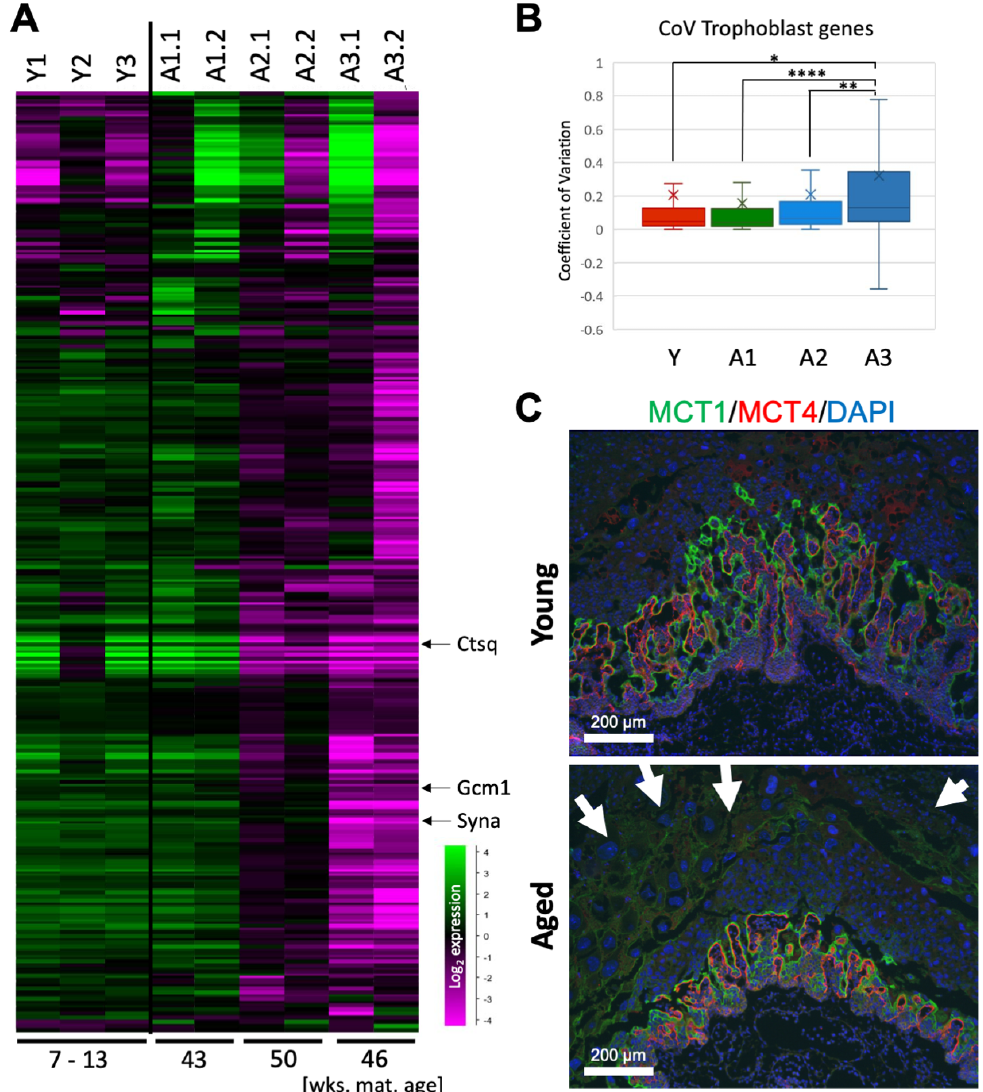
Figure 4. Impact of AMA on the trophoblast compartment of the placenta. ( A ) Heatmap depicting gene expression levels of trophoblast-enriched genes in placental samples. Key trophoblast marker genes are indicated. Gcm1 and Syna are syncytiotrophoblast markers while Ctsq is a sinusoidal trophoblast giant cell marker. Maternal age in weeks is shown on the bottom. ( B ) Coefficient of variation for trophoblast-enriched genes in the placenta of young an aged samples. Left to right: young litters, aged litter 1, aged litter 2, aged litter 3. The young litter group has 3 biological repli- cates, while aged litters 1, 2, and 3 have two replicates each. The “x” indicates the mean. Error bars indicate standard deviation. Statistical analysis was performed using a one-way ANOVA with Bonferroni’s post hoc test. * p < 0.05, ** p < 0.01, **** p < 0.0001. ( C ) Double immunofluorescence for MCT1 and MCT4, demarcating the syncytiotrophoblast layers I and II, respectively, in the mouse placental labyrinth. The fetal portion of the placenta and the labyrinth in particular tend to be un- der-developed in conceptuses to aged females. Additionally, obvious are vast numbers of tropho- blast giant cells (arrows) in the aged samples. Due to this “cliff-edge” effect, we repeated the differential gene expression analysis after excluding samples from aged litter 1, which resulted in a substantial increase in the number of DE genes per tissue based on maternal age, as well as in an increase in the number of overlapping DE genes across all tissue types (Figure S4B–D). We also as- sessed CoVs specifically for trophoblast-enriched genes (Figure 4B). The only significant